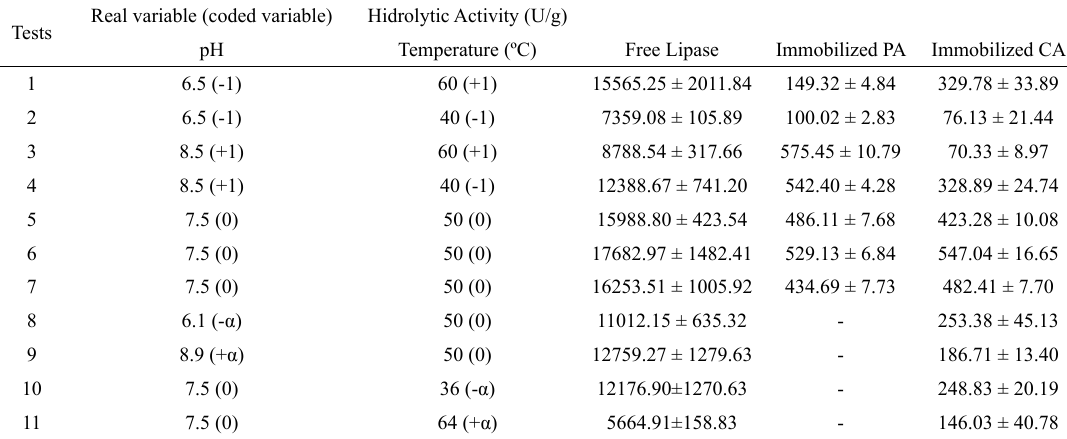
Table 2. Experimental design and hidrolytic activity obtained for different combination of pH and temperature.